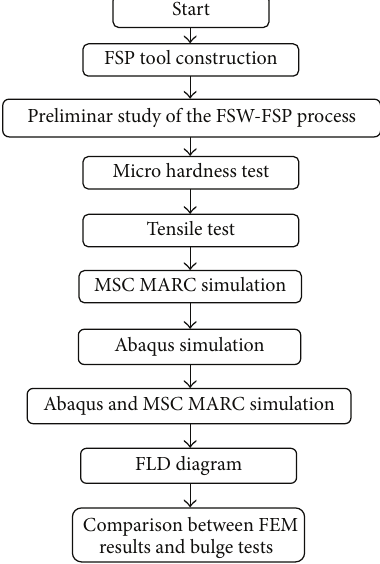
Figure 1: Schematic flowchart of the experimental